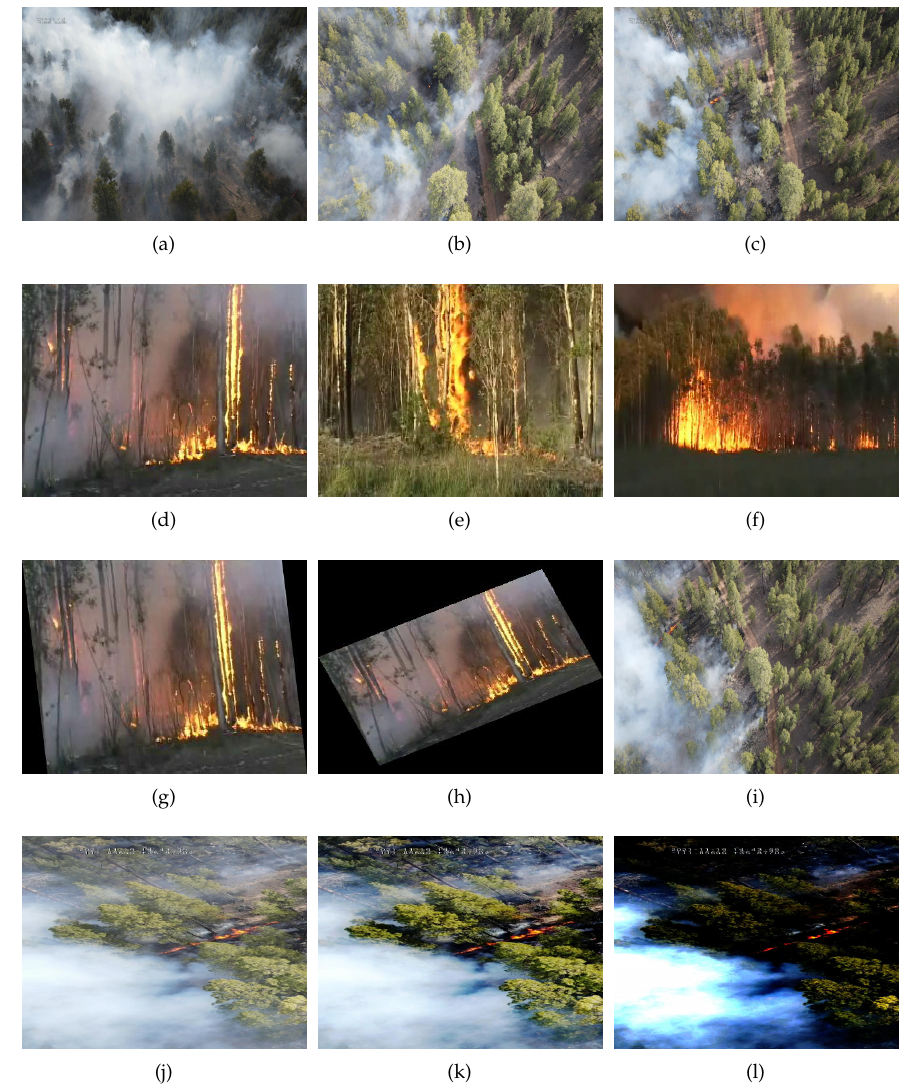
Figure 4. Images in row 1 ( a – c ) indicate Image2443, Image5835, and Image6577; row 2 ( d – f ) indicates frame89, frame318, and frame507; row 3 ( g – i ) shows shear, shear rotated, and horizontally flipped images of the dataset; and row 4 ( j – l ) shows the original, histogram-equalized and power law- transformed